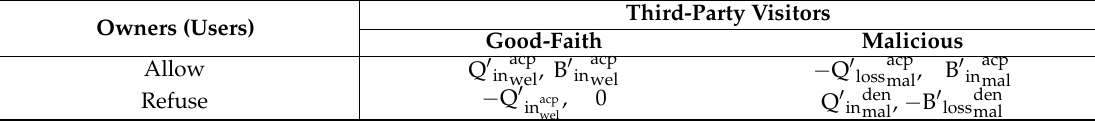
Table 3. Analyzing the reward matrix in the game-theoretic privacy protection